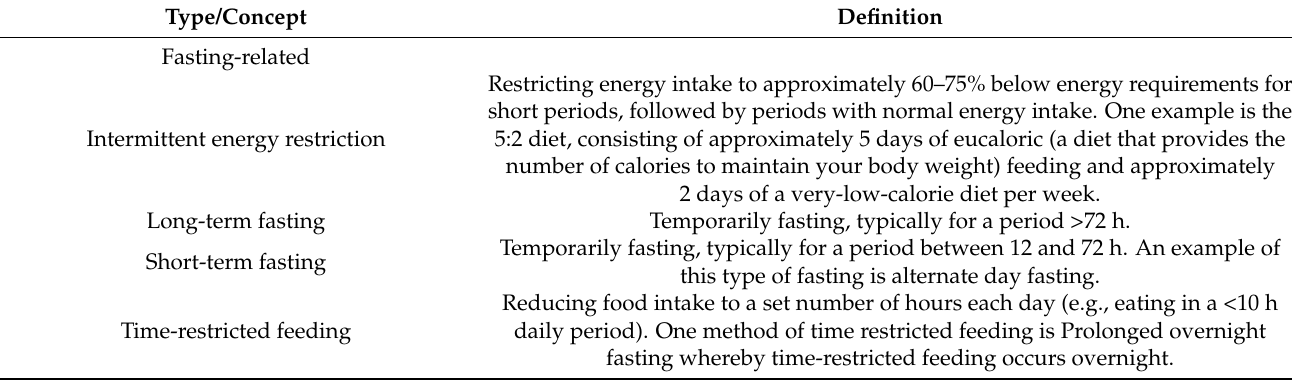
Table 1. Definitions of different types and concepts of fasting and